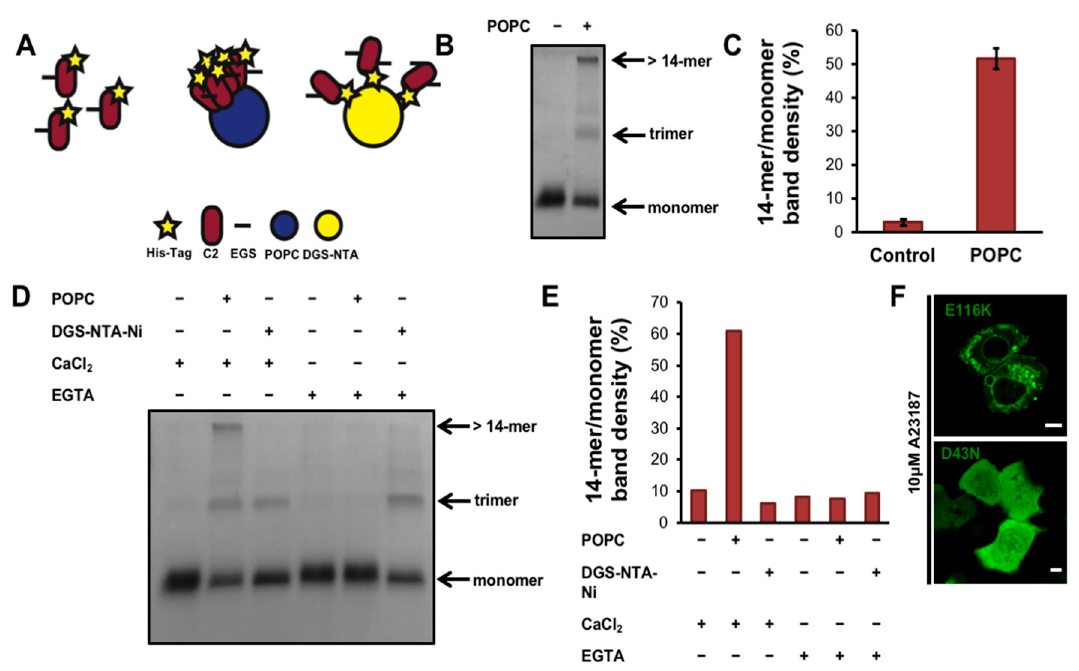
Figure 3. The cPLA 2 α C2 domain oligomerizes on lipid vesicles. ( A ) schematic of the crosslinking assay displaying the possible experimental outcomes. First, C2 domain with label is highlighted in the left panel of A, followed by the C2 domain binding to vesicles (POPC in blue), which would have captured oligomers in the presence of crosslinker (black line). Alternatively, at less protein density on the membrane surface, as in the presence of 1,2-dioleoyl- sn -glycero-3-[(N-(5-amino-1-carboxypentyl)iminodiacetic acid)succinyl] nickel salt (DGS-NTA) (right panel of A), C2 oligomers are proposed to be in lower quantity. ( B ) 35 µ L of 1.5 mM 1-palmitoyl-2-oleoyl- sn -glycero-3-phosphocholine (POPC) large unilamellar vesicles (LUVs) were incubated with 8 µ g of cPLA 2 α -C2 in 20 mM 4-(2-hydroxyethyl)-1-piperazineethanesulfonic acid (HEPES) (pH 7.4), 160 mM KCl and 50 µ M CaCl 2 for 30 min. The protein was crosslinked using 0.5 mM ethylene glycol bis(succinimidylsuccinate) (EGS) for 5 min, then the reaction was quenched with 150 mM Tris (pH, 8.0) for 5 min. The samples were run on 12% SDS-PAGE, stained with Coomassie blue, destained for 120 min, and analyzed with ImageJ. ( C ) Quantification of crosslinking experiments was completed in triplicate and normalized by dividing the > 14-mer band density to the monomer band density as determined with ImageJ. ( D ) POPC or 1,2-dioleoyl- sn -glycero-3-[(N-(5-amino-1-carboxypentyl)iminodiacetic acid)succinyl] nickel salt (DGS-NTA-Ni) lipids were incubated with bu ff er either containing 50 µ M CaCl 2 or 100 µ M ethylene glycol-bis( β -aminoethyl)-N,N,N’,N’-tetraacetic acid (EGTA) to chelate calcium. Each mixture was resolved using SDS-PAGE, stained with Coomassie blue and destained. ( E ) A representative quantification of D, which was performed independently in duplicate. Data was normalized as stated in C. ( F ) A549 cells were transfected at 70–90% confluency with either mEGFP-cPLA 2 α -E116K or mEGFP-cPLA 2 α -D43N and imaged 24 h post transfection. Cells were treated with 10 µ M A23187 for 30 min and representative images are shown.